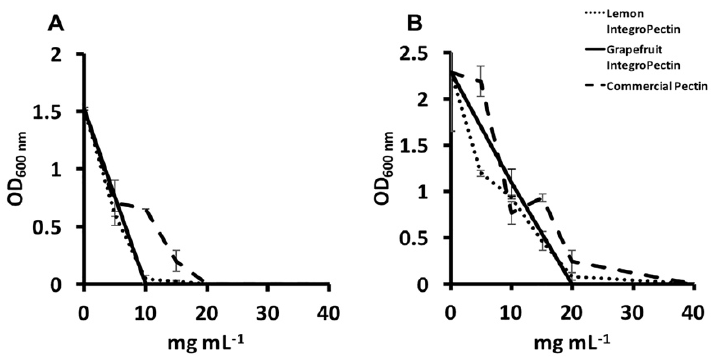
Figure 3 . Minimal inhibitory concentration of either lemon or grapefruit IntegroPectin, as well as the commercial citrus pectin against ( A ) Pseudomonas aeruginosa and ( B ) Staphylococcus aureus